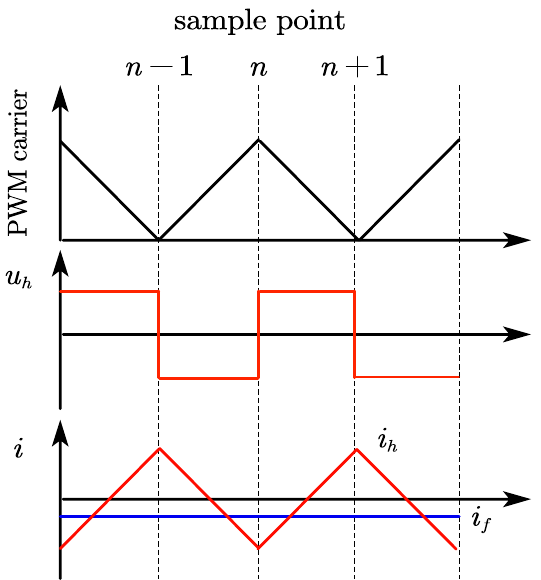
Figure 1. High-frequency signal and fundamental signal.